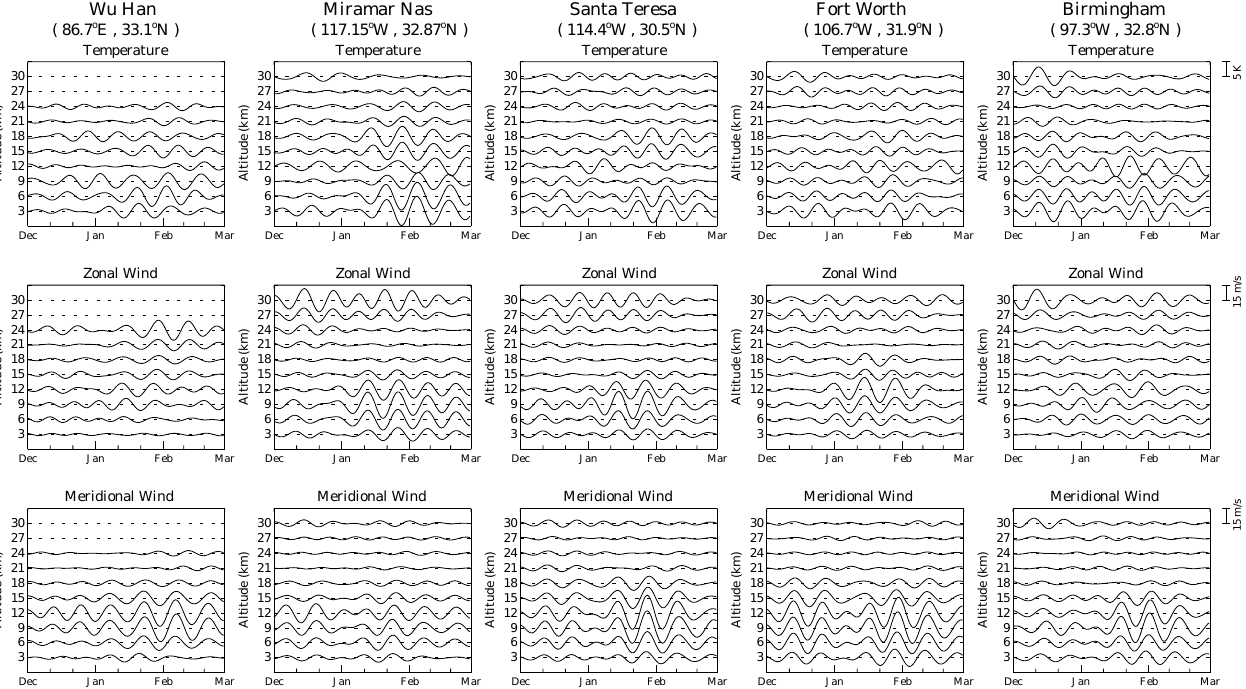
Fig. 7. The band-pass filter results of the temperature, zonal and meridional wind disturbances during December 2000 to February 2001. The bandwidth is 11–20 day from bottom to 30km and the intervals are 5K, 15ms − 1 , and 15ms − 1 for the temperature, zonal and meridional winds,